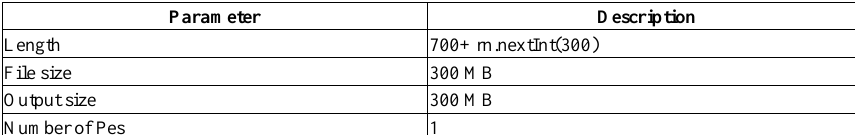
Table 2. Cloudlet Specification